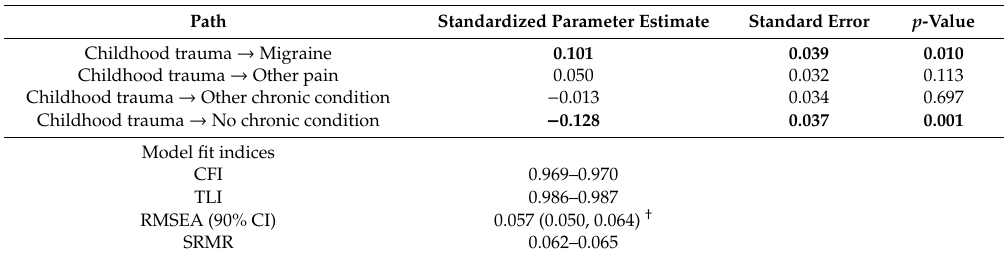
Table 4. Structural equation models (SEM) analyzing the direct e ff ect of childhood trauma (CTQ) on reported adulthood health